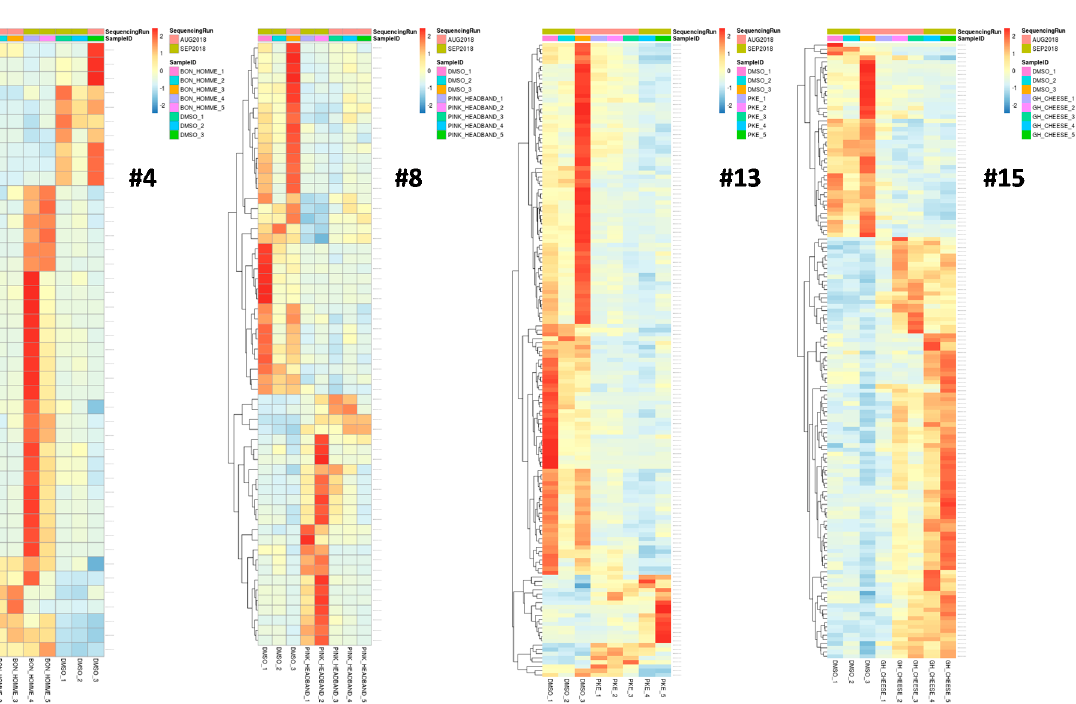
Table 5. CDEI testing results—EpiIntestinal.